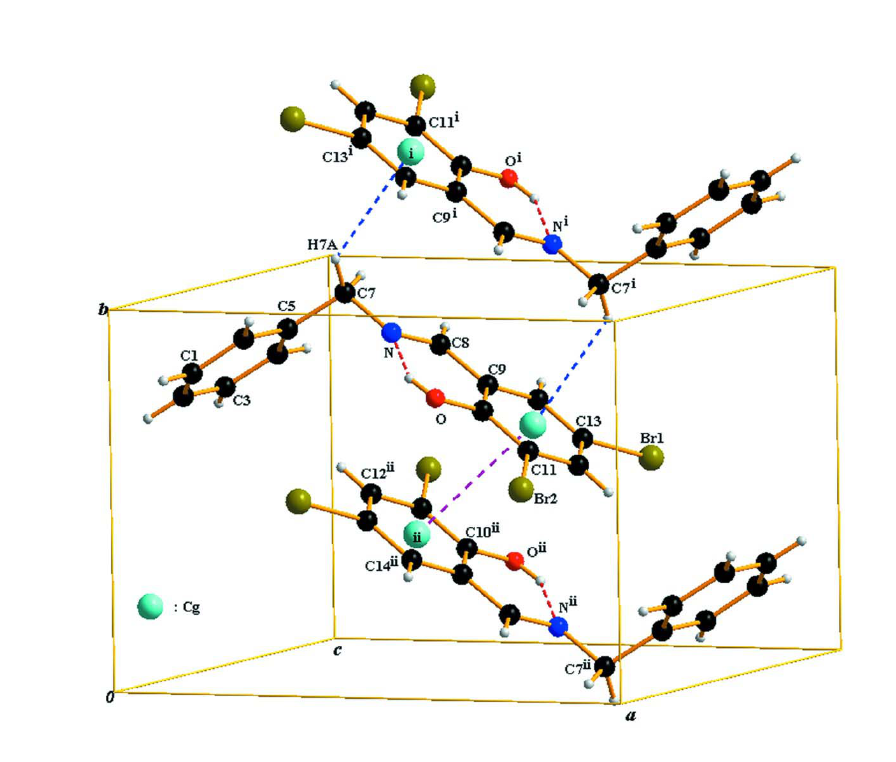
Figure 2 π ··· π , C—H··· π and N—H···O interactions (dotted lines) in the title compound. Cg denotes the ring centroids. [Symmetry code: (i) -x+1, -y+2, -z+1; (ii) -x+1, -y+1,